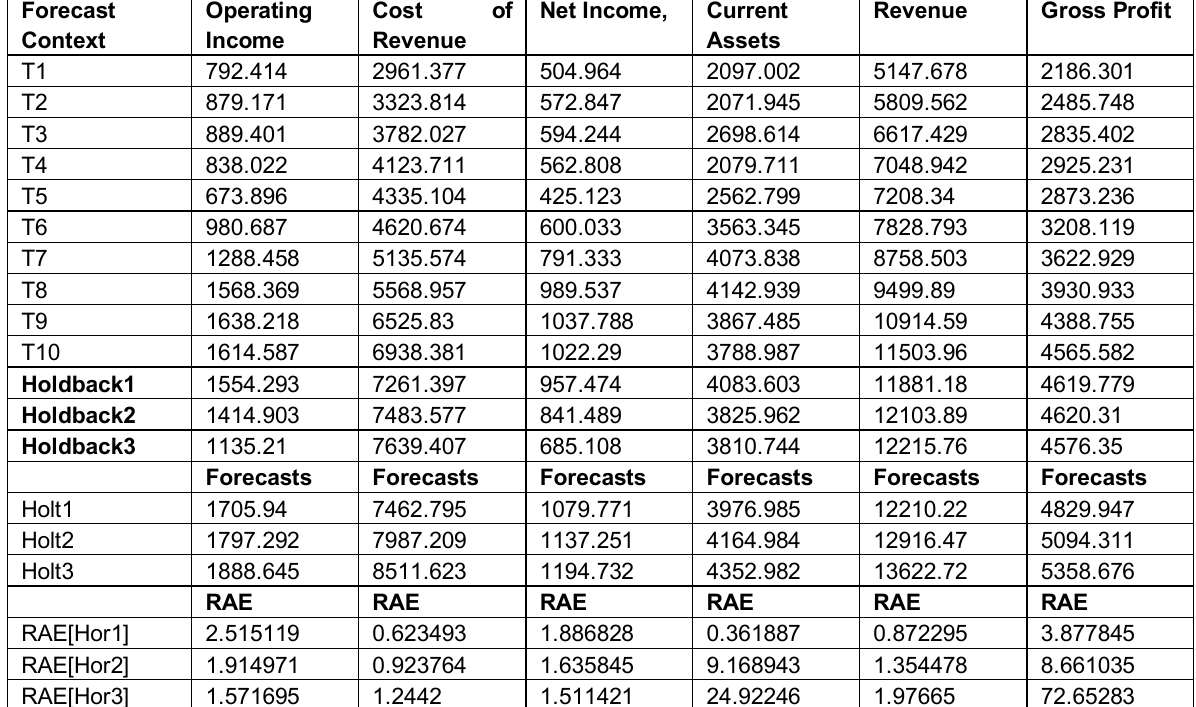
Table 5 : BBBY Holt Values and Projections for Three